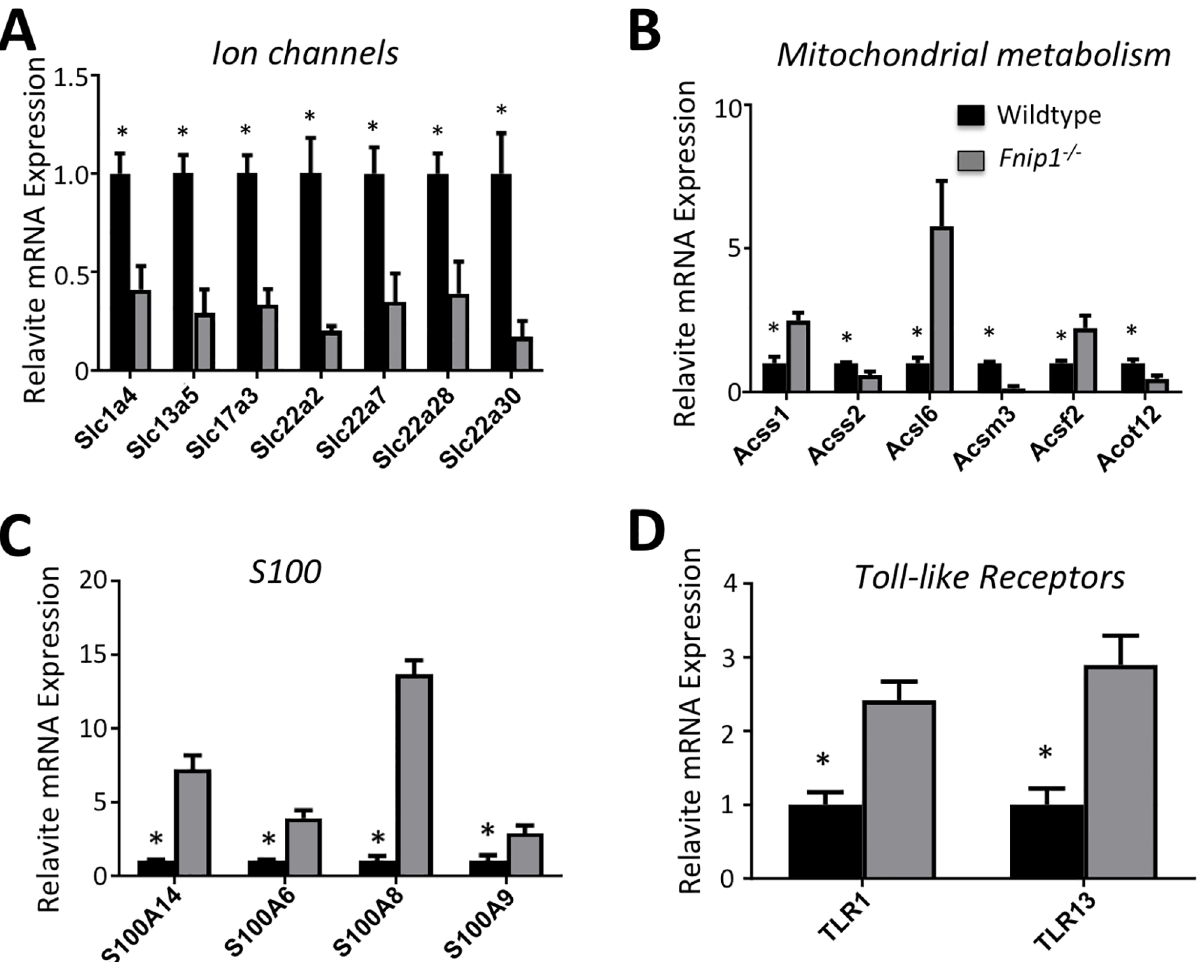
Fig 5. Real-time Quantitiative PCR analyses on kidney tissue from Fnip1 -/- versus wildtype mice. RNA was purified from Fnip1 -/- (n = 3) compared to WT (n = 3) kidney cortical tissue (mice were 11–18 weeks of age). Quantitative PCR was performed on cDNA derived from these tissues. Bar graphs show fold- differences in gene expression in Fnip1 -/- compared to WT mice (where WT is set to 1). (A) Genes encoding many of the solute carrier (Slc) family of transporter proteins are decreased in Fnip1 -/- compared to WT kidney tissue. (B) Altered expression of genes encoding acyl-CoA regulatory molecules and fatty acids regulatory molecules. (C) Expression of S100A genes including A14, 6, 8, and 9 are increased in Fnip1 -/- compared to WT kidney tissue. (D) Increased expression of TLR1 and 13 genes in Fnip1 -/- compared to WT kidney tissue. (n = 3 of each genotype, (cid:3) = p < 0.01).